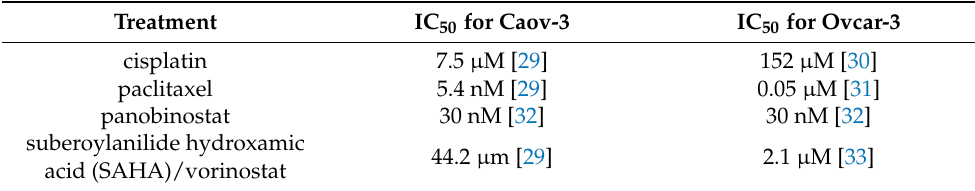
Table 2. IC 50 concentrations of Caov-3 and